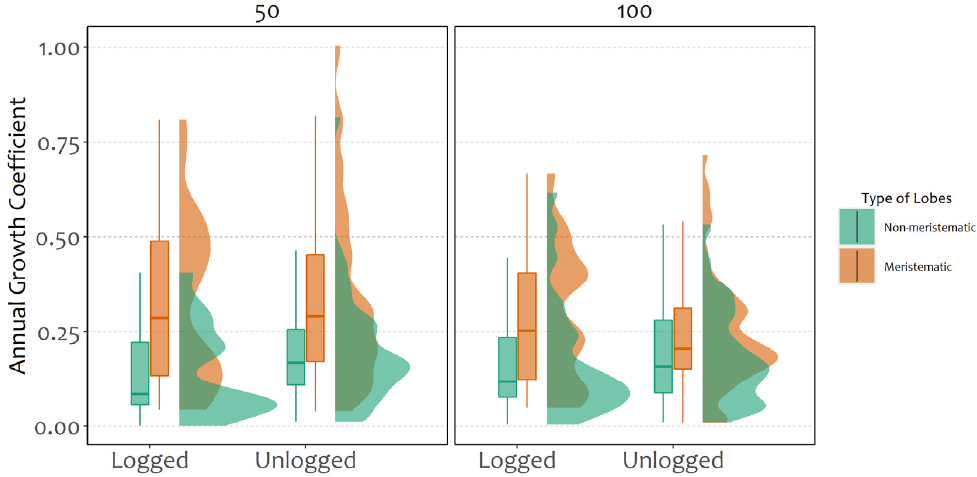
Figure 2. Annual growth coefficient for forest type (logged and unlogged), type of lobes (non-meristematic and meristematic) and different heights from the ground (50 and 100 cm).